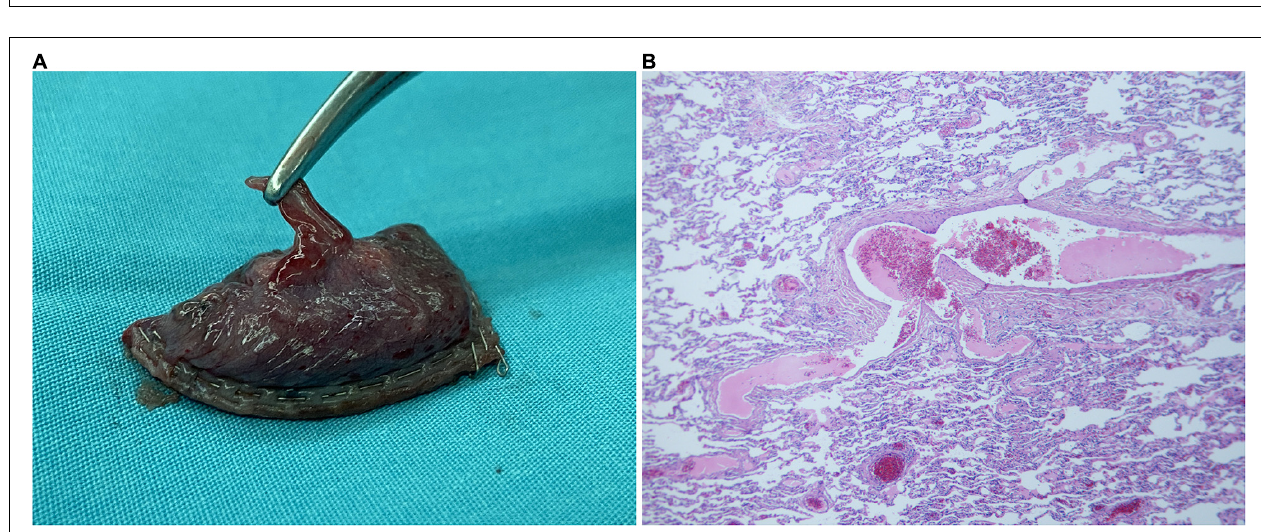
FIGURE 3 | Intraoperative exploration. (A) The abnormal branch of the left subclavian artery is ruptured, with a diameter of 2 mm. The proximal end is spasmodic, and the distal end forms thrombus, which is bleeding slowly. (B) The abnormal lung tissue in the apical segment of the upper lobe of the left lung, measuring 1 × 1 × 1 cm. The ruptured blood vessel supplying the abnormal lung tissue can be seen, with a diameter of 2 mm.